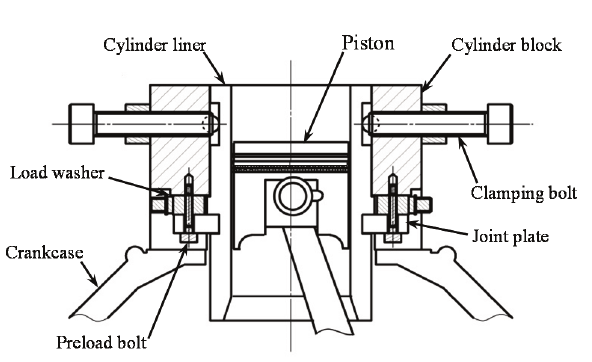
Fig. 3. Measurement unit of piston assembly friction with floating liner